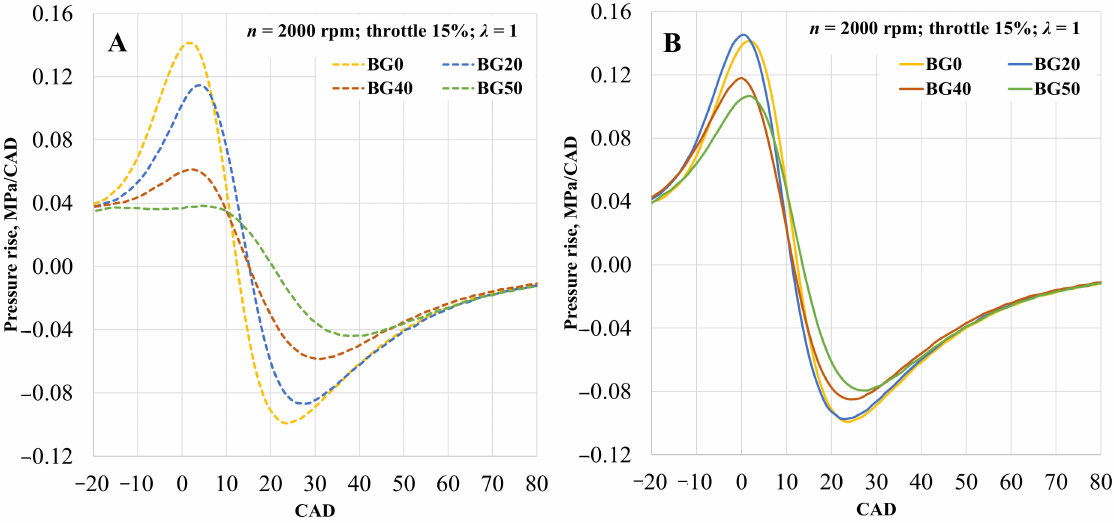
Figure 10. Change of the in-cylinder pressure rise depending on the volumetric fraction of CO 2 . ( A ) Constant ST, ( B ) Optimal